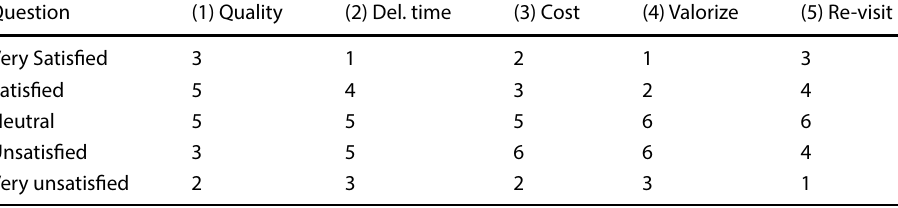
Table 3 Results of Reliability measurement of